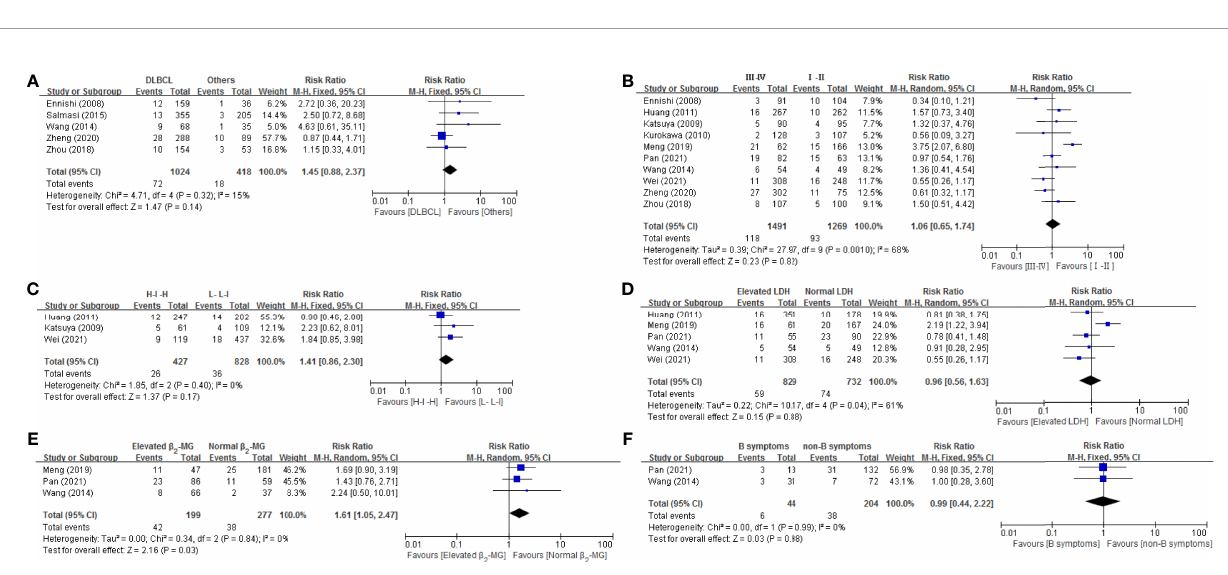
FIGURE 3 | Forest plot of studies among disease-related risk factors associated with IP development. (A) Histology. (B) Stage. (C) IPI. (D) LDH. (E) b 2-MG. (F) B